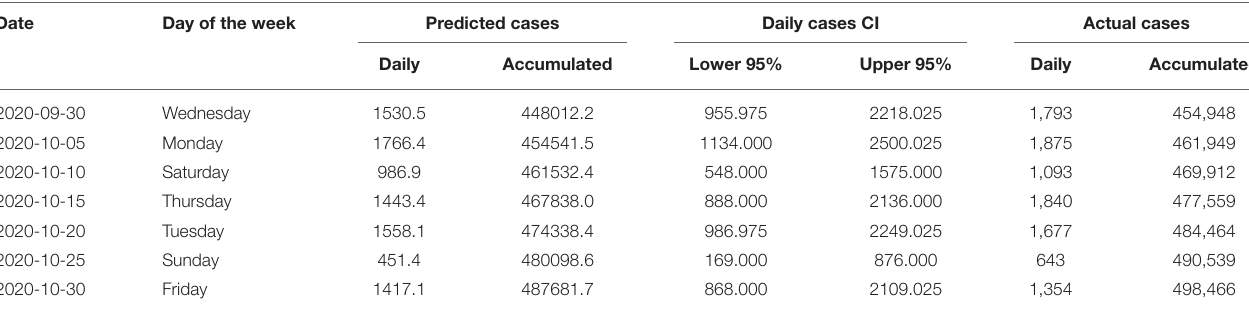
FIGURE 2 | Forecast for future cases until October 30th. TABLE 2 | Prediction of the fitted